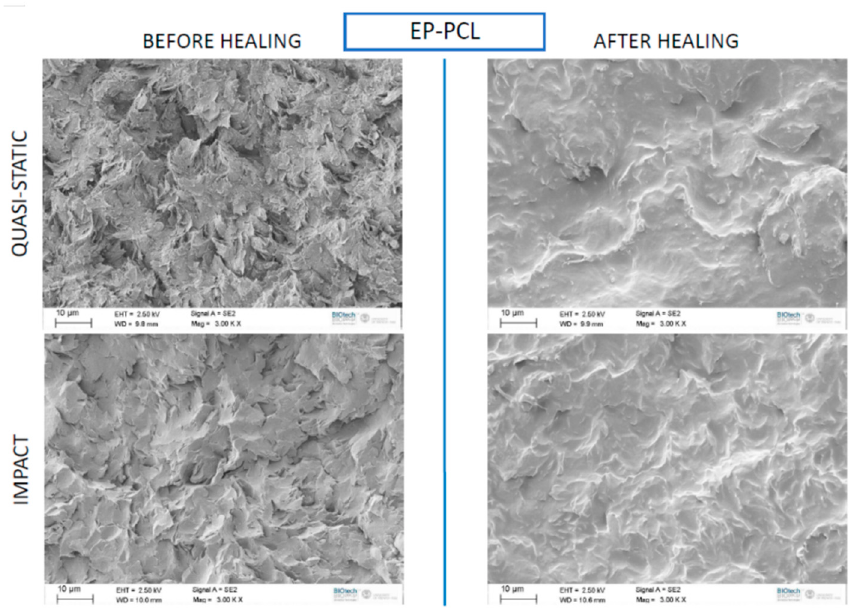
Figure 10. SEM micrographs of fracture surfaces of EP-PCL samples before and after the healing process.